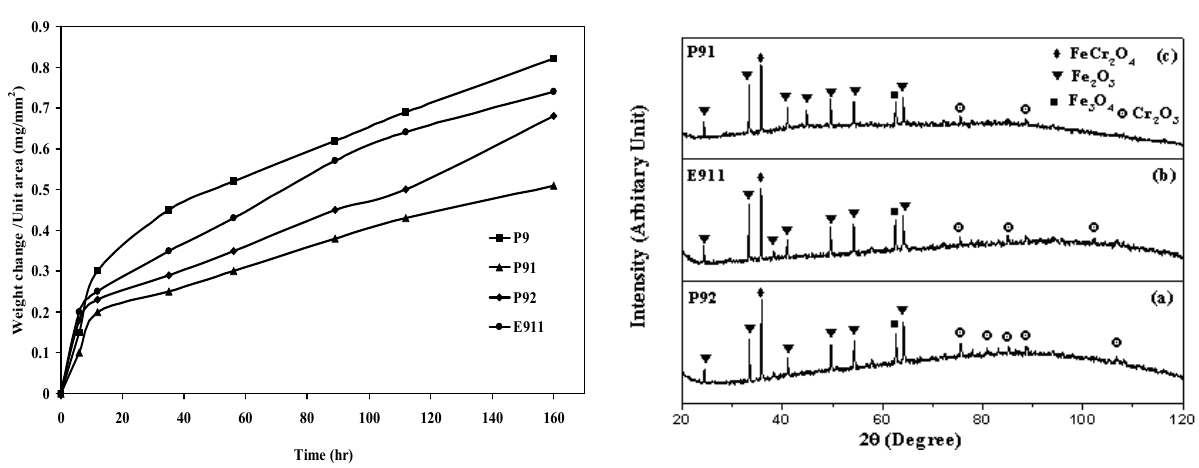
Figure 10. XRD-Pattern of alloys after oxidation in O 2 C 50 % H 2 O at 973 K.